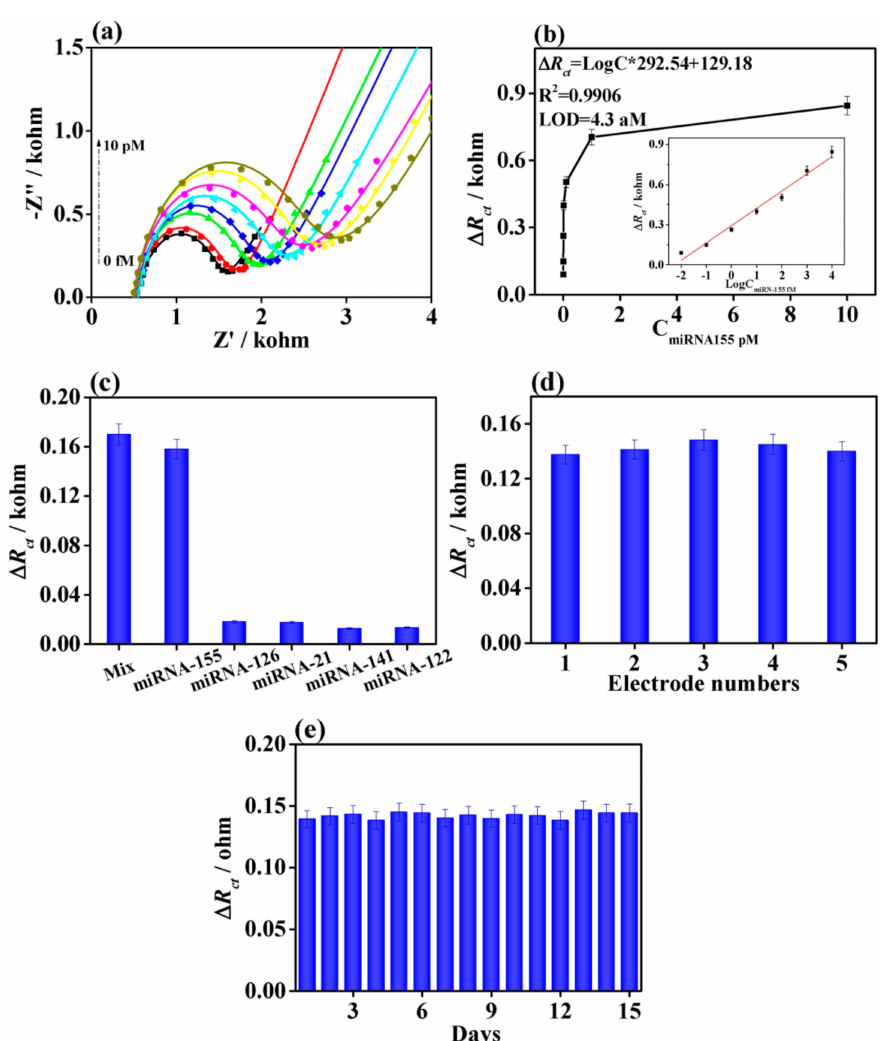
Figure 13. ( a ) Nyquist plots for detection of miRNA-155 from 0.01 to 10,000 fM using the MXene@QD-based aptasensor. ( b ) Dependence of ∆ R ct on the concentration of miRNA-155. ( c ) The ∆ R ct values of MXene@QD nanohybrid-based electrochemical aptasensor by separately